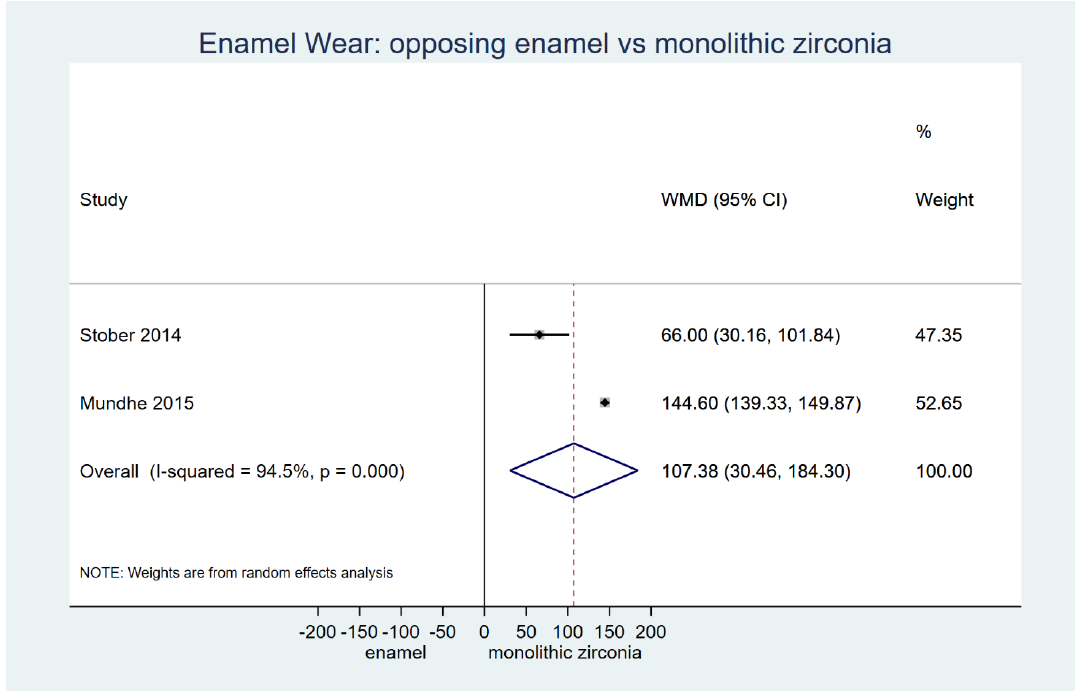
Figure 3. Random effects meta-analysis to explore antagoni st enamel wear (μm) for monolithic Figure 3. Random e ff ects meta-analysis to explore antagonist enamel wear ( µ m) for monolithic zirconia zirconia versus natural enamel in clinical studies. versus natural enamel in clinical